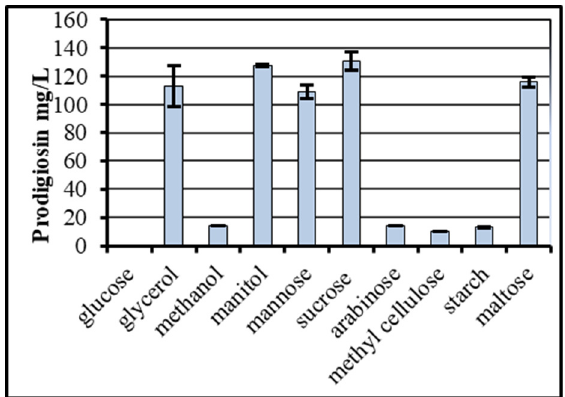
Fig. 1. The effect carbon source on prodigiosin production by S. marcescens in chemically defined liquid